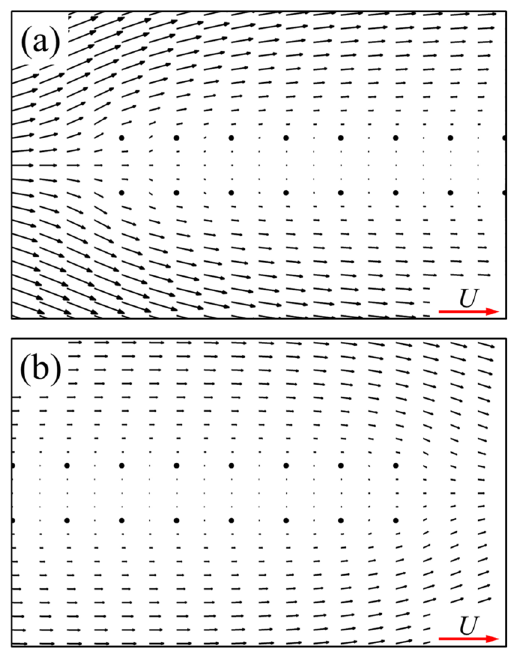
Figure 18. The plot of non-dimensional velocity vector around ( a ) the leading edge and ( b ) the trailing edge of two bristled wings with a smaller distance in between ( W / c =